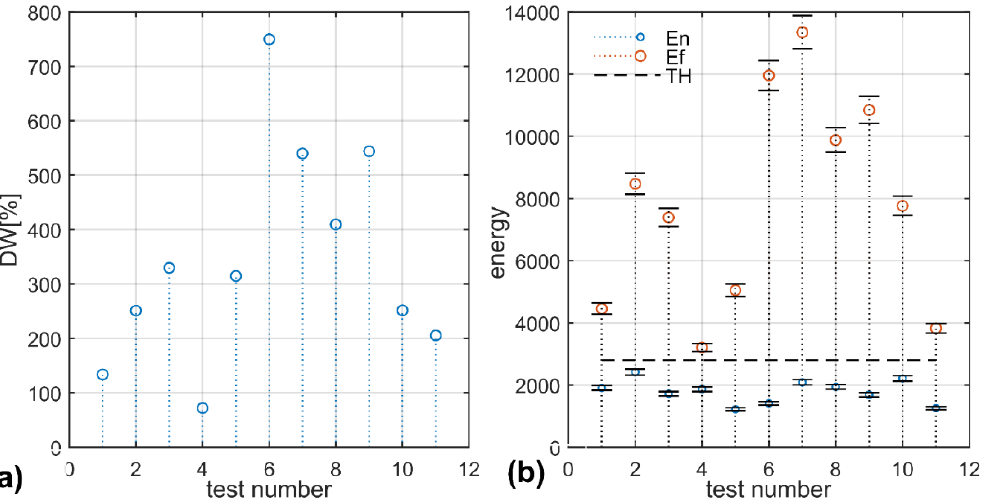
Figure 7. Results: ( a ) DW function (blue circles: maximum DW value for each test); ( b ) energies Ef-red circles: faulty wheel vibration energy; En-blue circles: normal wheel vibration energy) and threshold (TH-thresholding values of vibration energy difference between faulty and normal wheels).